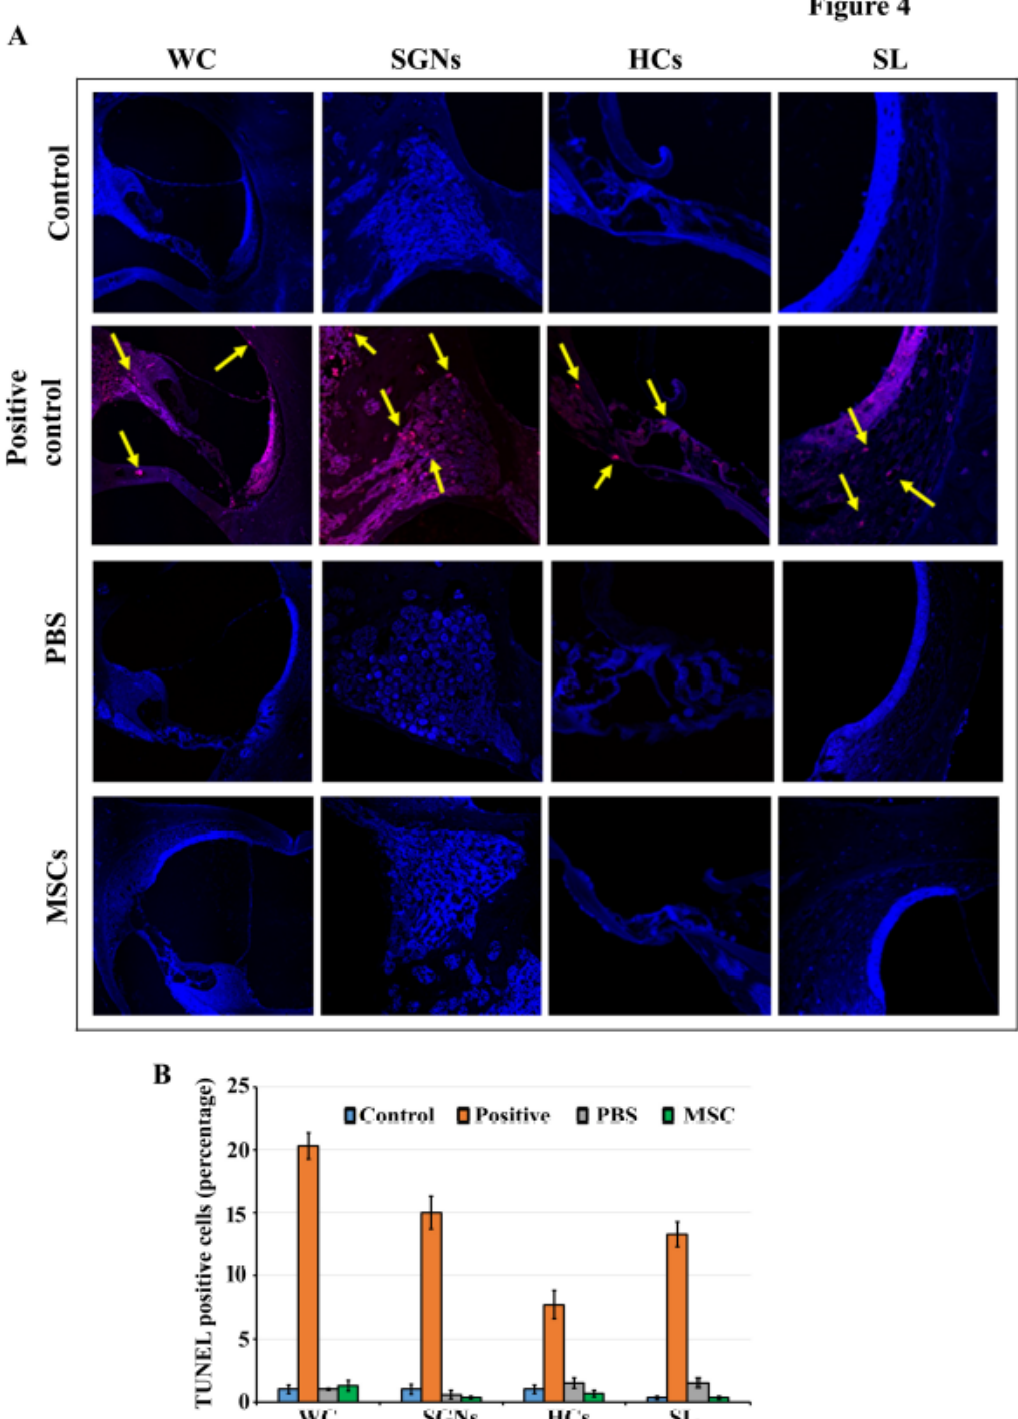
Figure 4. Transferase dUTP nick end labeling (TUNEL) staining: Rat cochlear slices were subjected to TUNEL immunostaining to determine cell death. ( A ) Cochleae harvested from rats that received BM-MSCs, PBS injected, or control group showed no or sparse staining whereas those from positive group showed intense staining (red color). Blue color shows DAPI staining. ( B ) The percentage of TUNEL positive cells were calculated and graphed. Arrows indicate cell death in positive control group. WC: whole cochlea; SGNs: Spiral Ganglion Neurons; HCs: Hair Cells; SL: Spiral Ligament.